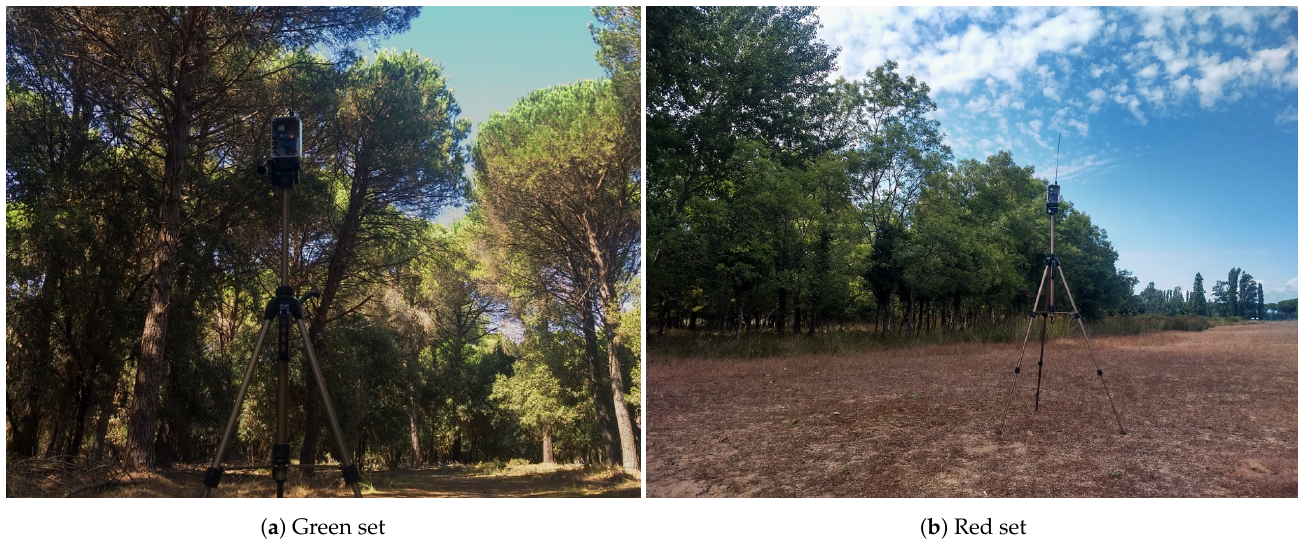
Figure 8. Image showing the environment in the green and red